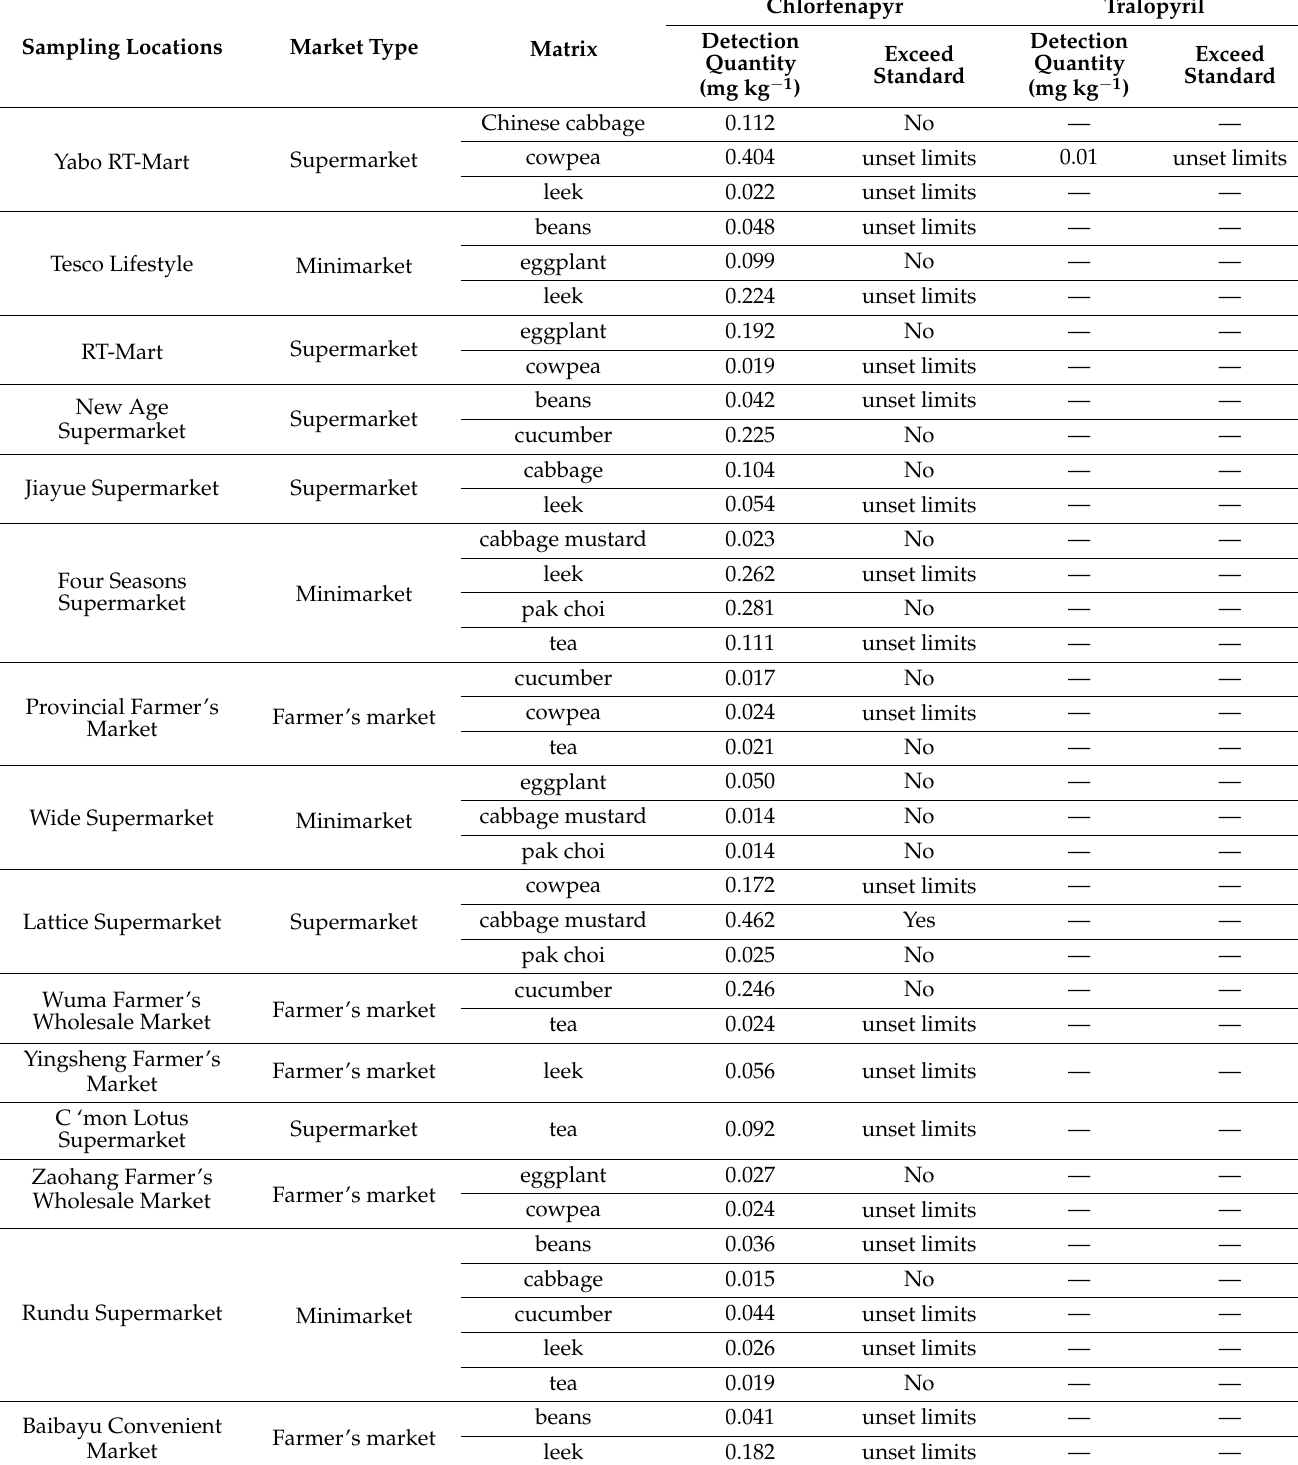
Table 2. Residue and limit evaluation of chlorfenapyr and tralopyril bromide in market monitoring